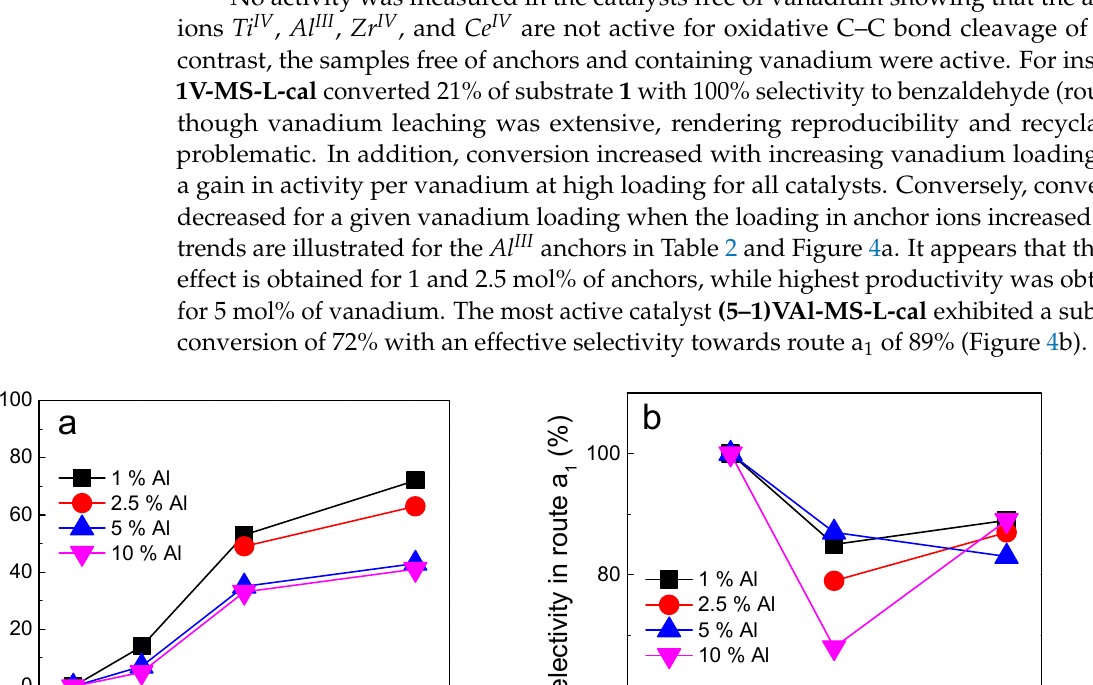
6 2.6. Product Analysis and General Selectivity Trends The main product obtained using the lignin model molecule, substrate 1 , was always benzaldehyde, formed almost exclusively at low conversions (Table S6). This suggests that the fastest pathway proceeds by both C–O and C–C bond cleavage (Scheme 1, route a1). The production of methanol was difficult to measure precisely as this volatile molecule partially evaporates between the aperture of the well on cooling and subsequent sample analysis. One should keep in mind that the quantities to analyze are small as each reactor of the high-throughput systems contains 6 mg of catalyst and 0.025 mmol of substrate in 0.5 mL of acetonitrile. Under these conditions, the carbon mass balance could not be ac- curately determined, and conversion was estimated by the decrease in substrate concen- tration. Thus, the selectivity was calculated from the concentration of benzaldehyde pro- duced according to routes a 1 and a 2 , together with methyl benzoate, produced exclusively via route a 2 , taking into account the stoichiometry of the reactions involved (Scheme 1). It was observed for several catalysts that benzoin methyl ether, produced by C–H bond cleavage of substrate 1 , does not react further under our reaction conditions. Benzoin me- thyl ether and/or methylbenzoate systematically appeared at high conversions, both fin-